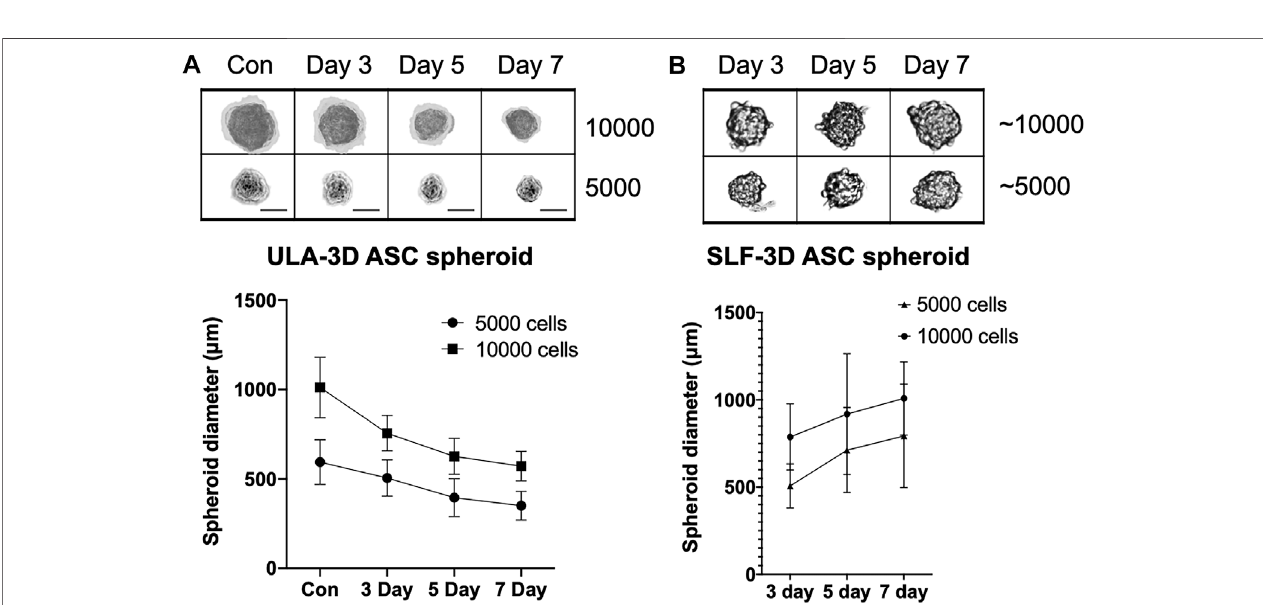
FIGURE 3 | The relationship between culture time and spheroid diameter changes in the two types of spheroids. The relationship between seeding densities and the formation of (A) ULA-3D spheroids and (B) SLF-3D spheroids. Human ASCs were seeded onto ULA plates at densities of 10,000 and 5,000 cells/cm 2 . Scale bars, 100 μ m. Images are representative of more than fi ve independent experiments. Graphs show the means of three independent experiments, each performed in duplicate ± SE. n (cid:2) 5; ** p < 0.01.